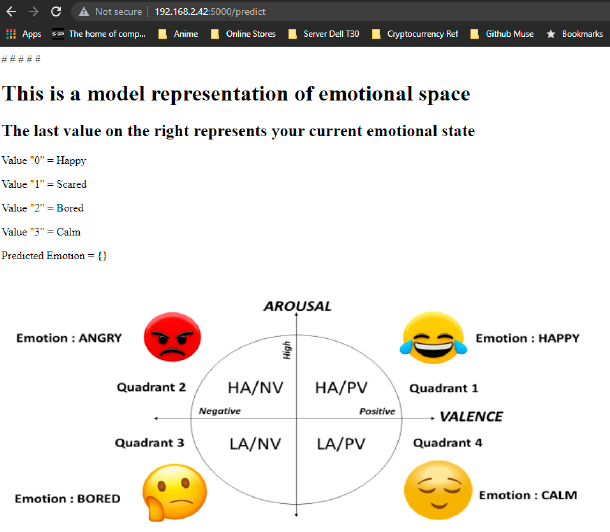
Figure 9. Live web page of the emotion prediction system.